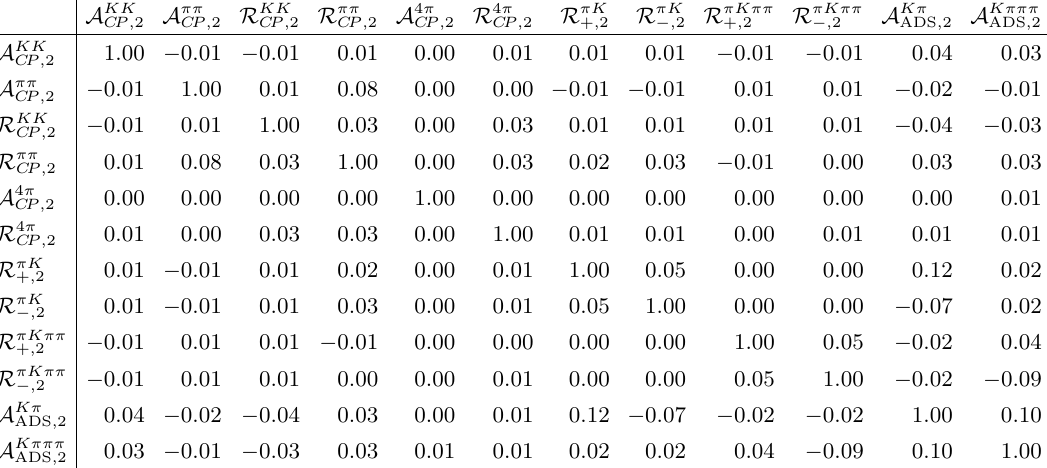
Table 6 . Combined statistical and systematic correlation matrix for the principal observables in Run 2 data only.